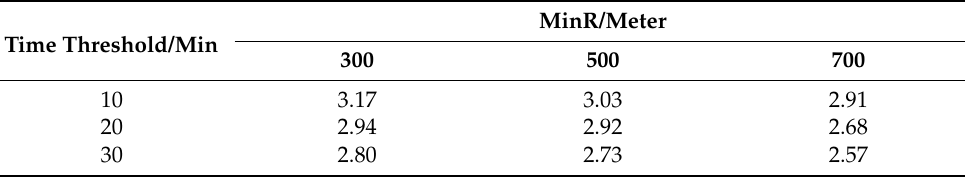
Table 4. The results of the average trip frequency under different thresholds. Time Threshold/Min